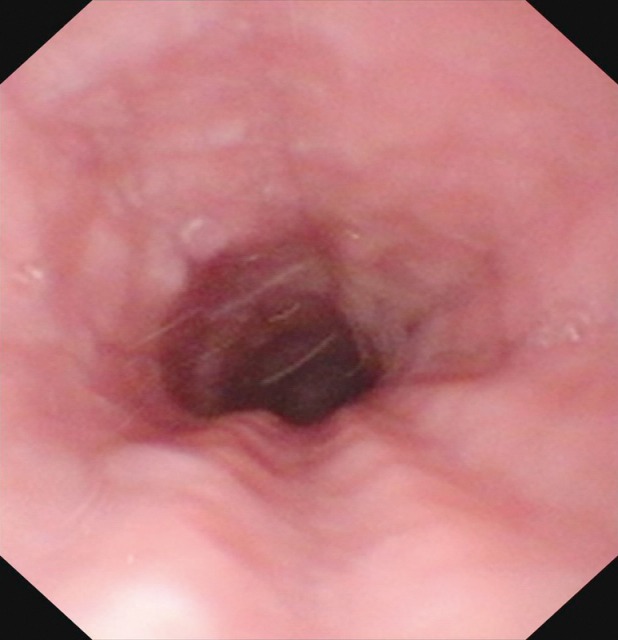
Eosinophilic esophagitis with persisting dysphagia. Condition after several esophagoscopies with removal of bolus. Increasing rigidity of the esophageal wall with problems of bolus transportation in the esophageal phase.